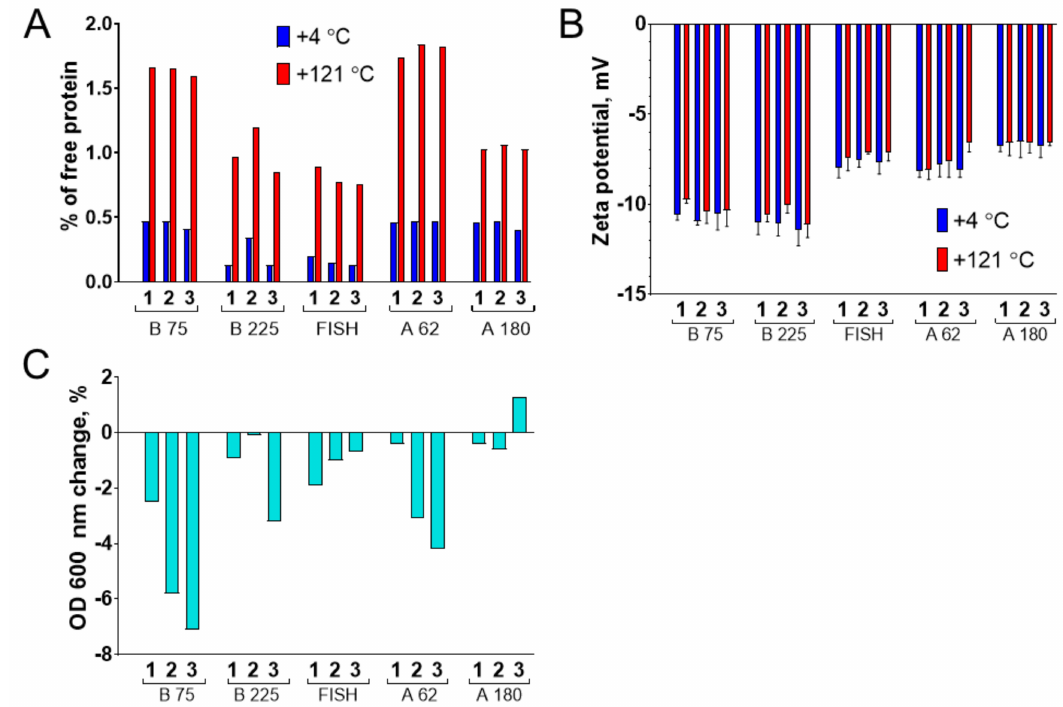
Figure 11. Properties of sterilized (+121 ◦ C) and non-sterilized (+4 ◦ C) nanoparticles. ( A ) The percentage of free protein in relation to nanoparticle concentration; ( B ) zeta potential at a pH 7; ( C ) change of turbidity of the gelatin nanoparticle suspensions after sterilization. Mean zeta potential values of three technical replicates are shown, mean ±